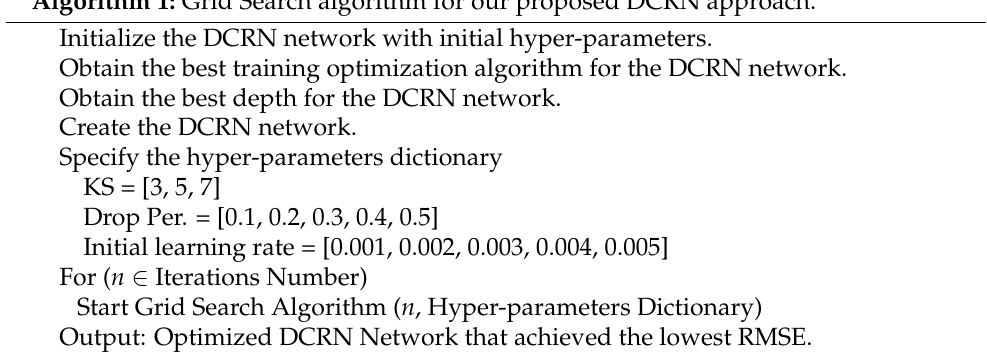
Algorithm 1: Grid Search algorithm for our proposed DCRN